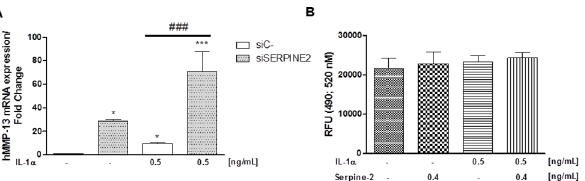
Fig 3. A. Human MMP-13 mRNA expression in T/C-28a2 chondrocytes transfected with a siRNA against SERPINE2 (siSERPINE2, 10nM) or a non-targeting control siRNA (siC-, 10 nM) in presence or not of IL-1 α (0.5 ng/mL) for 24 h. B. MMP-13 endogenous catalytic activity was measured in the conditioned medium of OA human primary chondrocytes after recombinant SERPINE2 (0.4 ng/mL) treatment in presence or not of IL-1 α (0.5 ng/mL) for 24 h. * P < 0.05 and *** P < 0.001 vs siC- transfected cells; ### P < 0.001 vs siC- plus IL-1 α -stimulated chondrocytes.